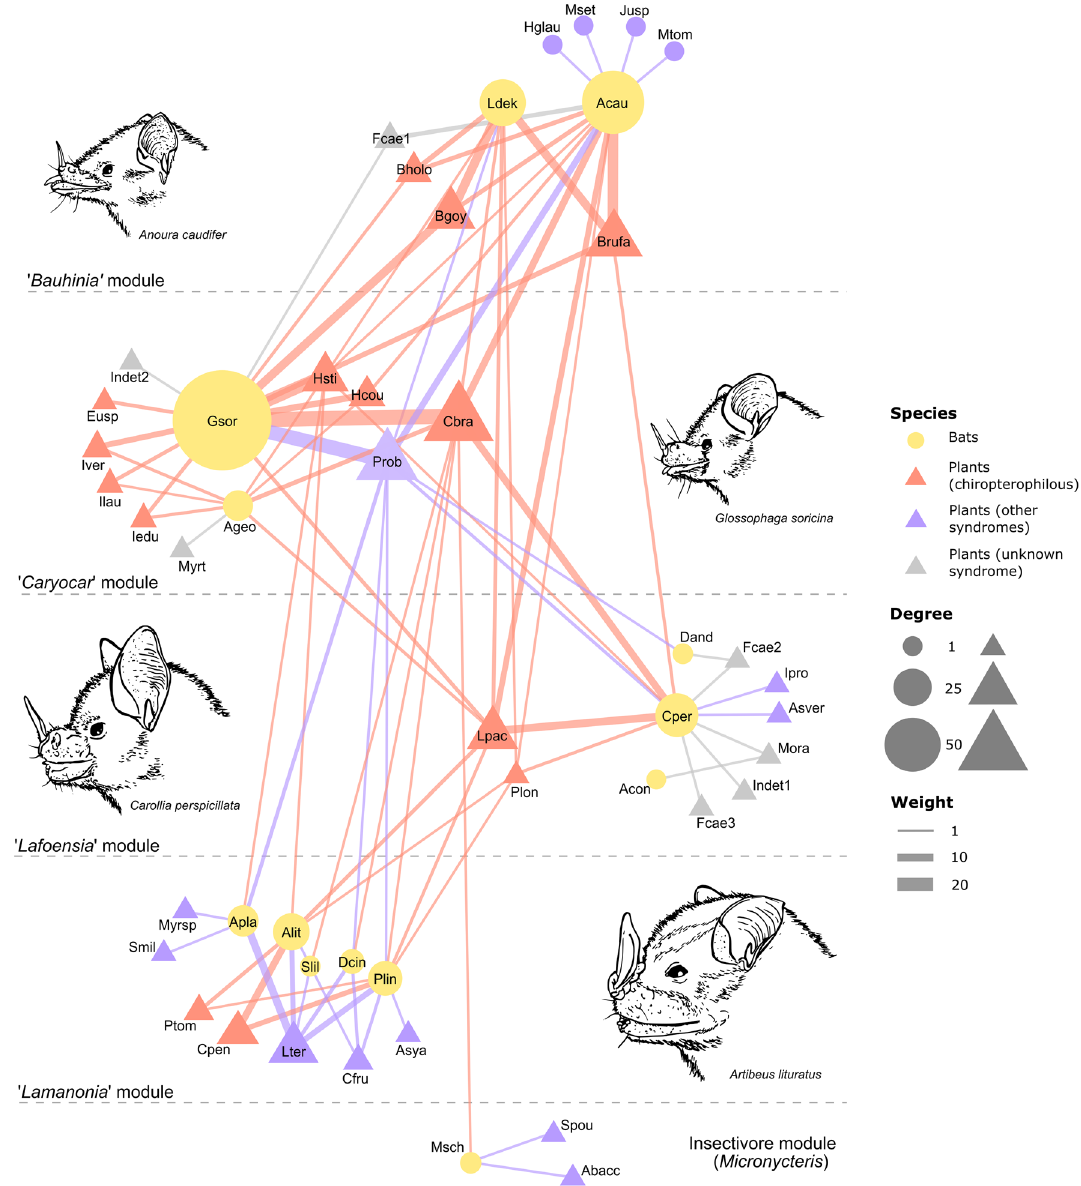
Figure 2. Interaction network between flower-visiting phyllostomid bats and plants in a savanna of central Brazil. Nodes represent species and lines, pairwise interactions. Line width corresponds to interaction weight (frequency) and node size to a species’ degree, or the sum of a species’ interactions. Plants are divided into chiropterophilous, non-chiropterophilous, or unknown syndromes. Modules in the network are divided by dashed lines and accompanied by a schematic illustration of the most important bat species in the module. Species codes are found in Supplementary Tables S1 and macrostructure) and non-random distribution of pairwise interaction frequencies (microstructure) indicate an effect of morphological traits of bats and plants on network assembly. Module separation was constrained by species phylogeny and associated with the functional morphology of both bat groups and their visited plants, which serves as a smaller-scale parallel to the role of phylogenetic constraints as the first filter of interactions between bat-plant interactions at large, continental scales 20 . This morphological “filter” seems to operate via the typical forbidden links mechanism, excluding interactions that are mechanically unlikely to occur (e.g., short-snouted and non-hovering frugivores and delicate tubular flow- ers) and leading to higher-scale network patterns. Although a single-taxon network in a broader sense (i.e., comprising the family Phyllostomidae only), the inclusion of frugivores of the Stenodermatinae and Carollinae subfamilies likely was the cause of the emergence of the observed compound structure, as these groups can show a good performance as consumers on a specific type of exploitable floral resource (robust and accessible flowers